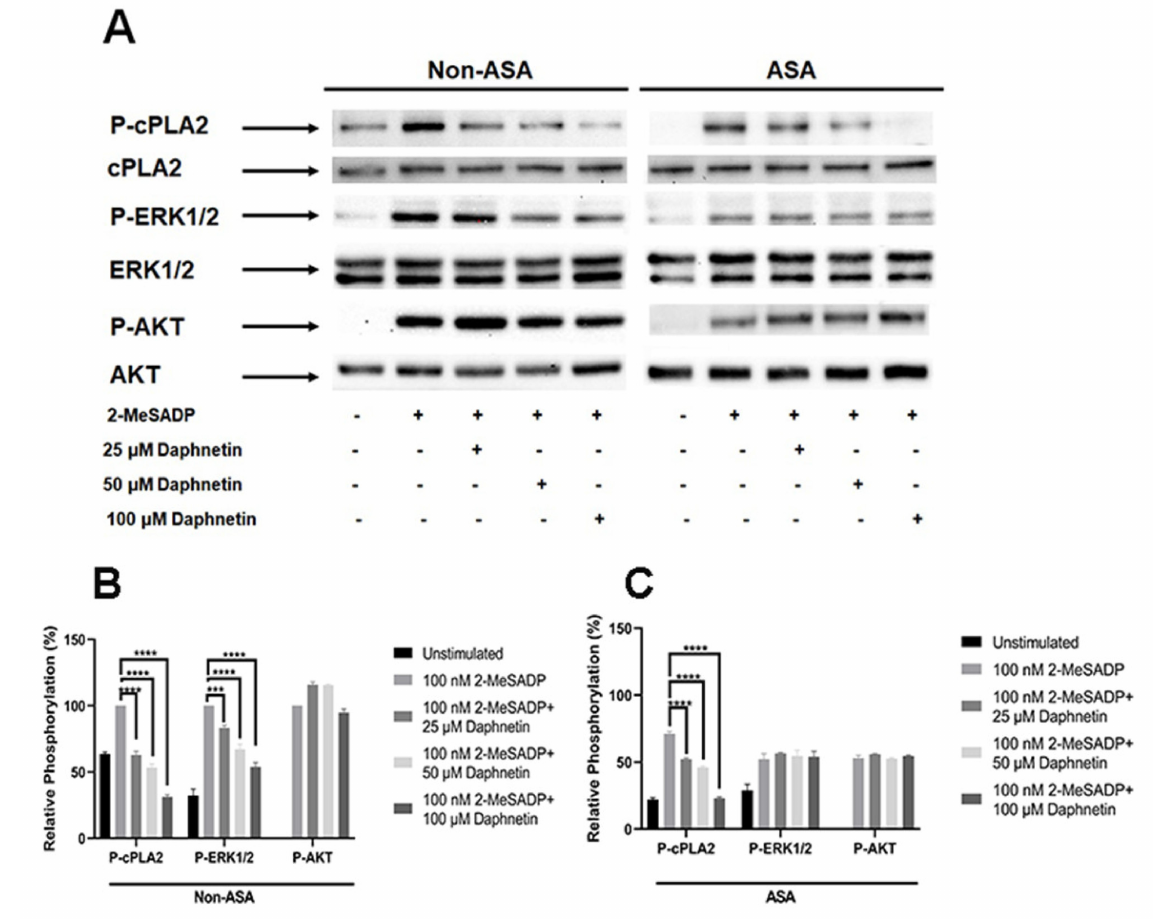
Figure 6. The effect of daphnetin on cPLA 2 and ERK phosphorylation induced by 2-MeSADP in platelets. ( A ) Non-ASA- and ASA-treated washed platelets were stimulated with 100 nM 2-MeSADP in the presence of different concentrations of daphnetin at 37 ◦ C for 2 min. The lysate volume corresponding to the same number of platelets was loaded. The membrane was probed with anti- phospho-cPLA 2 (Ser505), anti-cPLA 2 , anti-phospho-ERK, anti-ERK, anti-phospho-AKT (Ser473), or anti-AKT antibodies. Data shown are representative of three independent experiments ( n = 3). Blots in ( B ) non-ASA- and ( C ) ASA-treated platelets are quantified and presented as mean ± SE ***, p < 0.001; ****, p <